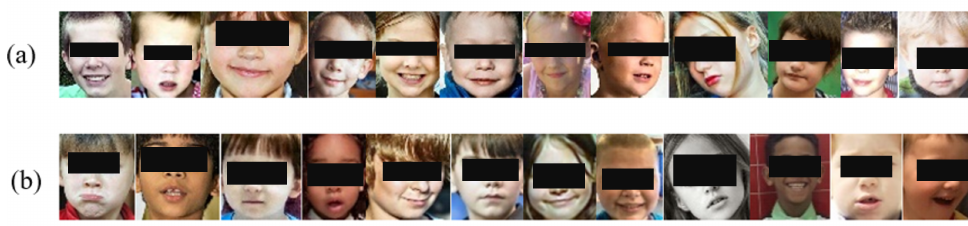
Figure 9. The 12 images in the top row are of ( a ) autistic children, and those misclassified as normal and vice-versa for the images are shown in ( b ) the lower row, which belong to normal control child (prediction of Xception).